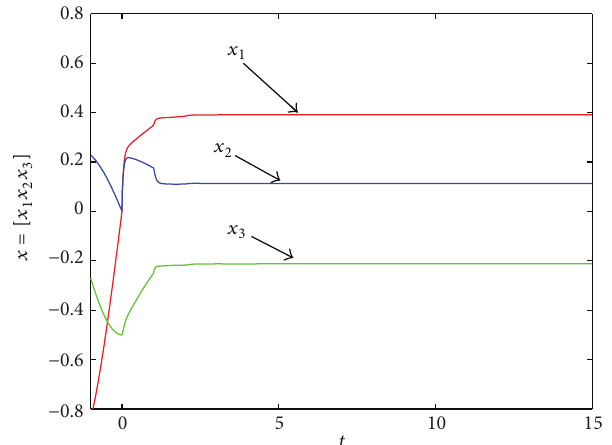
Figure 3: Time-domain behavior of the state variables 𝑥 1 , 𝑥 2 , and 𝐼(𝑡) = (10,5, −10) 𝑇 𝑥 3 when